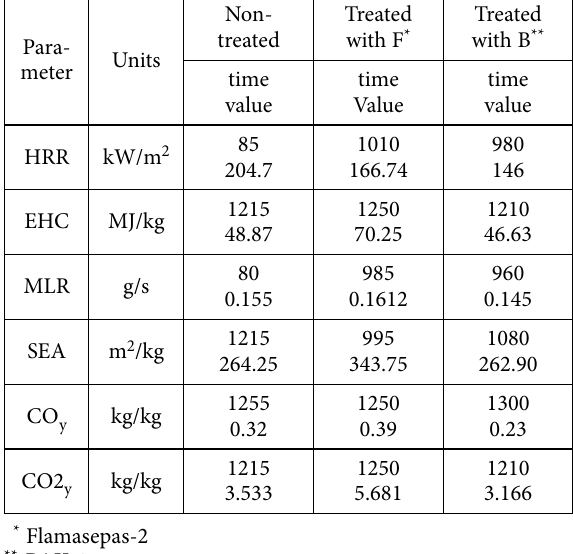
Table 1. Maximum values of selected combustion parameters and corresponding times for non-treated and treated pine timber specimens (with piloted ignition)